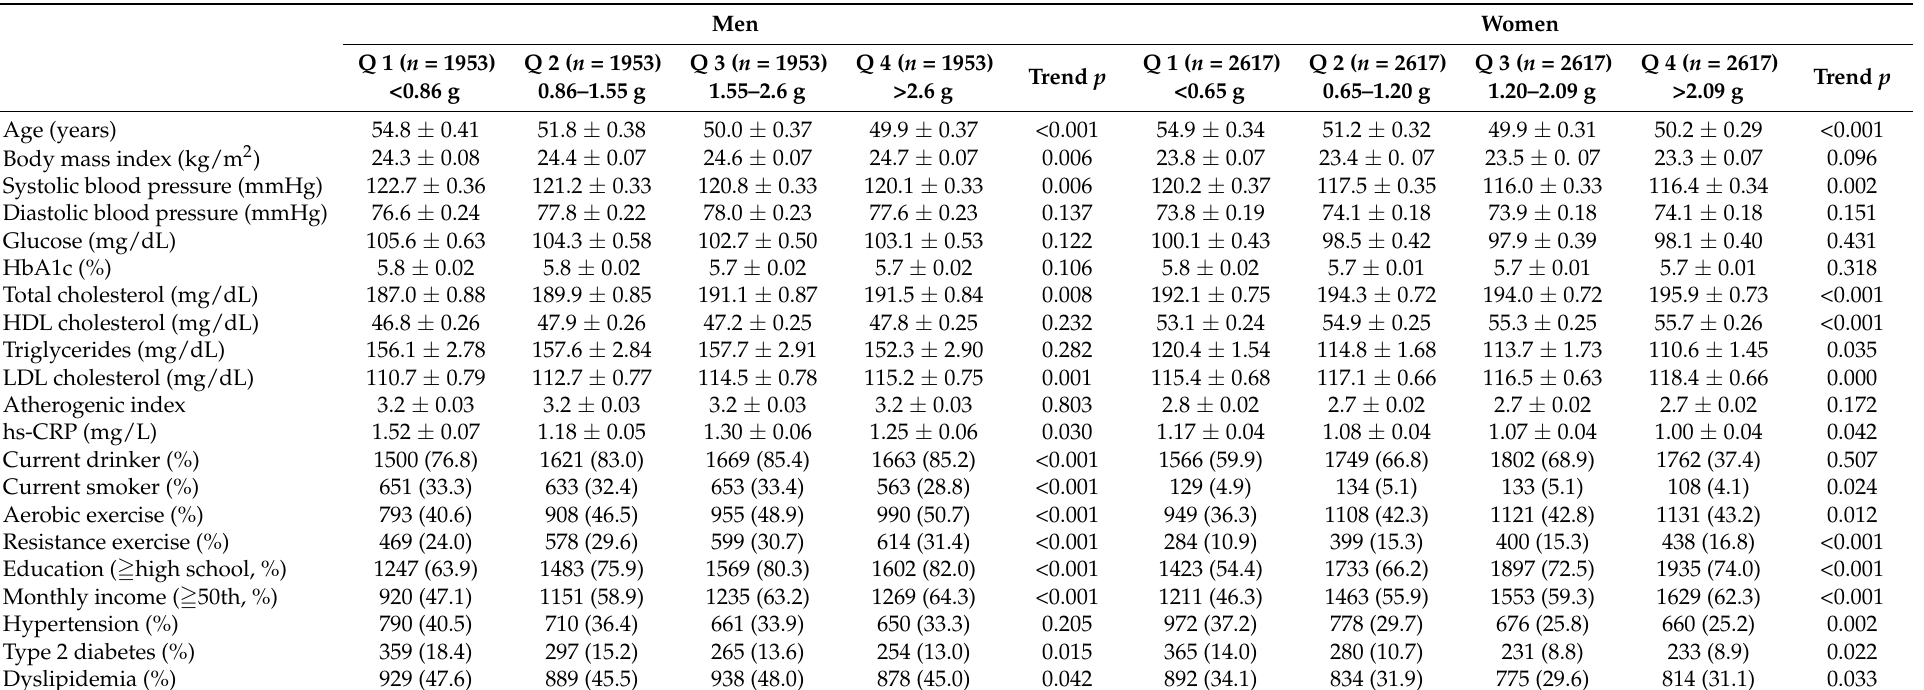
Table 1. General characteristics of the participants according to dietary omega-3 polyunsaturated fatty acids